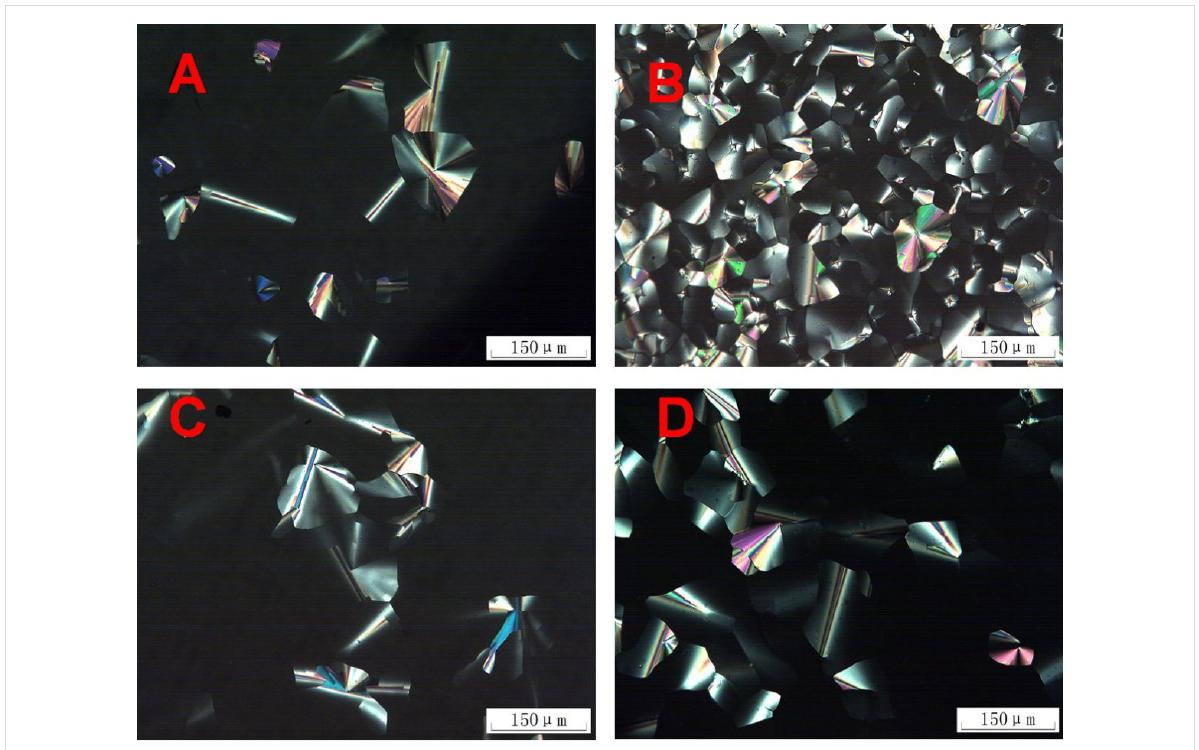
Figure 1: Optical photomicrographs of the triphenylene DLC monomers. (A) 2 at 40 °C; (B) 3a at 45 °C; (C) 3b at 62 °C; (D) 3c at 67 °C.